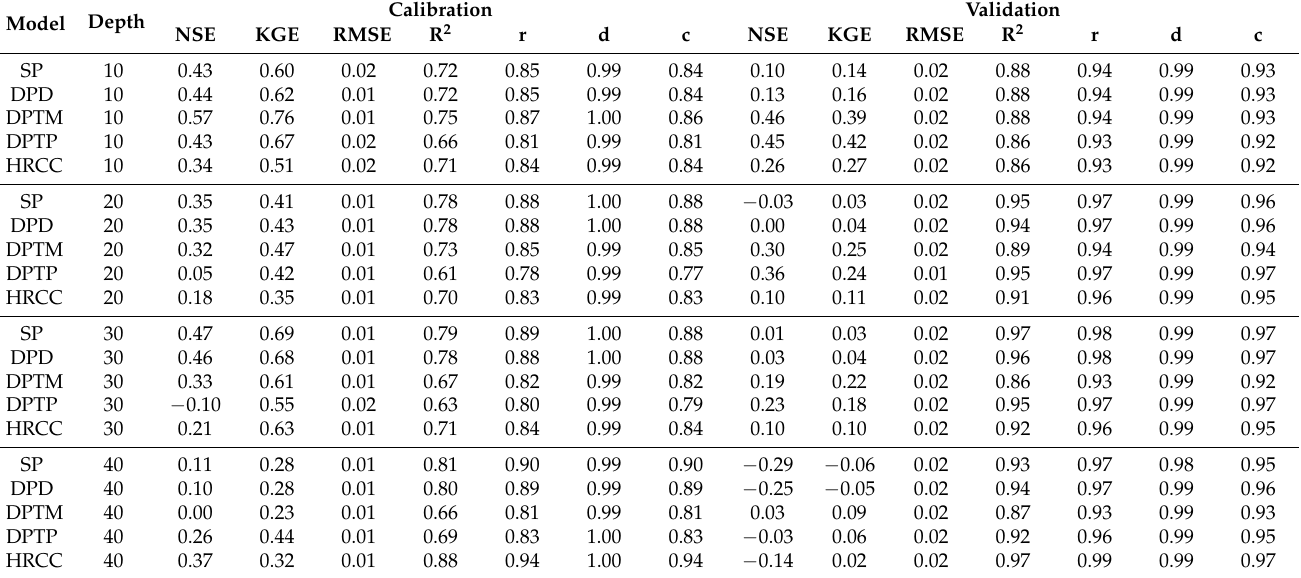
Table 5. Statistics of the models’ adjustments for the hydraulic data measured in the Caatinga